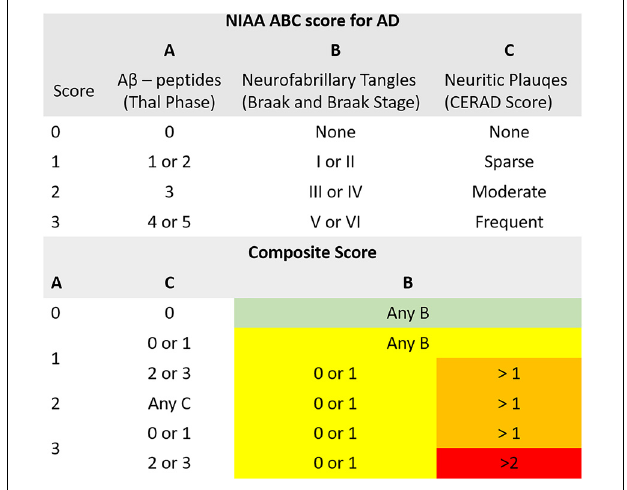
FIGURE 1 | Illustration of the composite “National Institute on Aging – Alzheimer’s Association” (NIAA) ABC score for neuropathological change of Alzheimer’s disease (AD). The score comprises hallmark lesions attributed to AD, (A) A β -peptides according to Thal phase, (B) neurofibrillary tangles described by Braak and Braak stage and (C) neuritic plaques described by the CERAD score. While the ABC score issued by the NIAA has four levels, describing absence of (green color, n = 16) or presence of low (yellow color, n = 15), intermediate (orange color) or high (red color) neuropathological change, it was collapsed to three levels for this analysis to ensure sufficient group sizes. Thereby, intermediate and high change were merged into one group ( n =